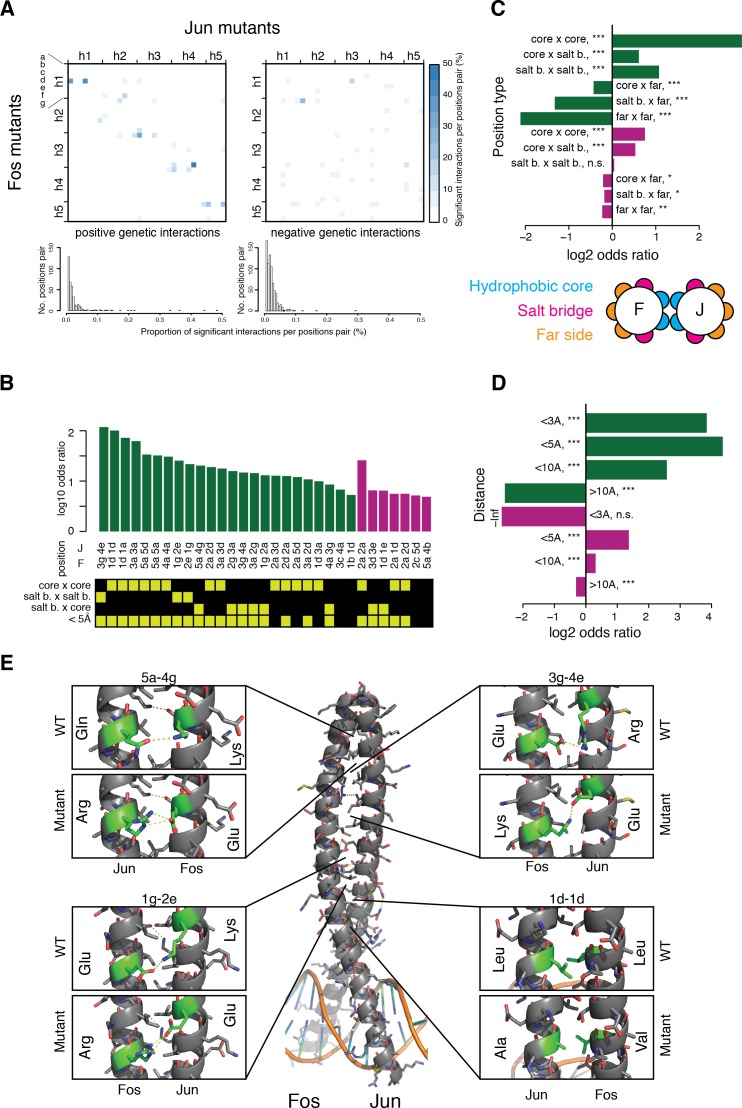
Structural genetic interactions.(A) Heatmap (top) and distribution (bottom) of percentage of significantly (absolute genetic interaction score > 0.1, FDR < 0.2) positive (left) or negative (right) genetic interactions per pairs of position. Pairs of positions without any significant interactions were excluded from the distribution (bottom). (B) Pairs of position significantly enriched in positive (green) or negative (purple) genetic interactions (Fisher’s exact test, FDR = 10%). Each pair of position was classified according to its heptad position type and the distance between the two position (bottom matrix, yellow cells). (C–D) Enrichment for significantly positive (green) or negative (purple) genetic interactions between different position types (C) and at different distance threshold between the two positions (D). *, FDR < 0.1. **, FDR < 0.01. ***, FDR < 0.001. n.s., non-significant. (E) Example of structural interactions in the Fos-Jun complex (pdb: 1fos). Dashed yellow lines represent polar interactions predicted by pymol and the mutant structures were drawn using the pymol mutagenesis function.